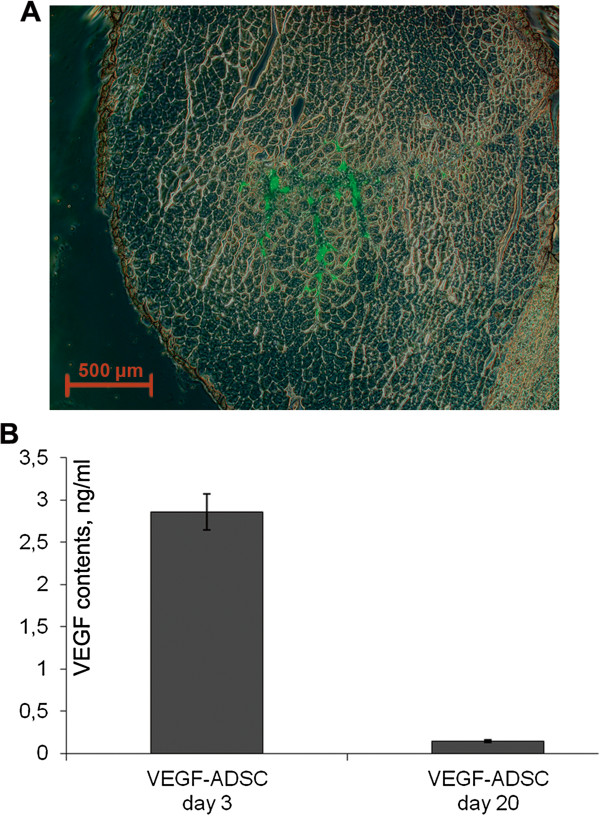
Human ADSC viability and VEGF expression after transplantation to ischemic murine muscle. A. Representative image of m. tibialis anterior section from “GFP-ADSC” group obtained at day 7 after ischemia induction and GFP-ADSC injection, 50× magnification. GFP-positive cells are distributed in tissue around injection site. B. Analysis of VEGF165 content by ELISA in explants culture medium from “ADSC”, “GFP-ADSC”, “VEGF-ADSC” groups obtained at days 3 and 20 after cell trasplantation.